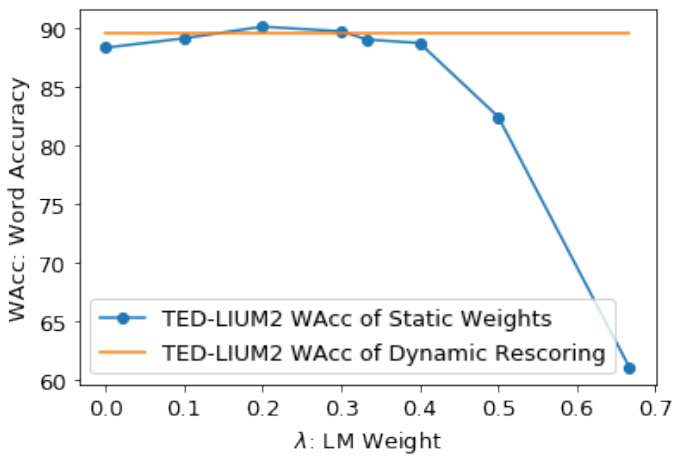
Figure 6. Results on